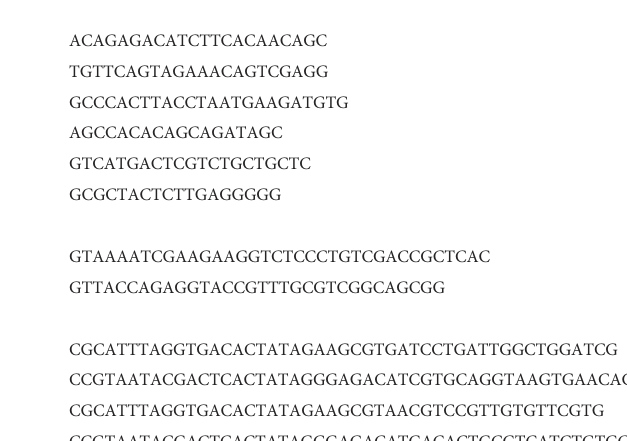
TABLE 1 primers sequences used for ORF cloning, ISH and qPCR.